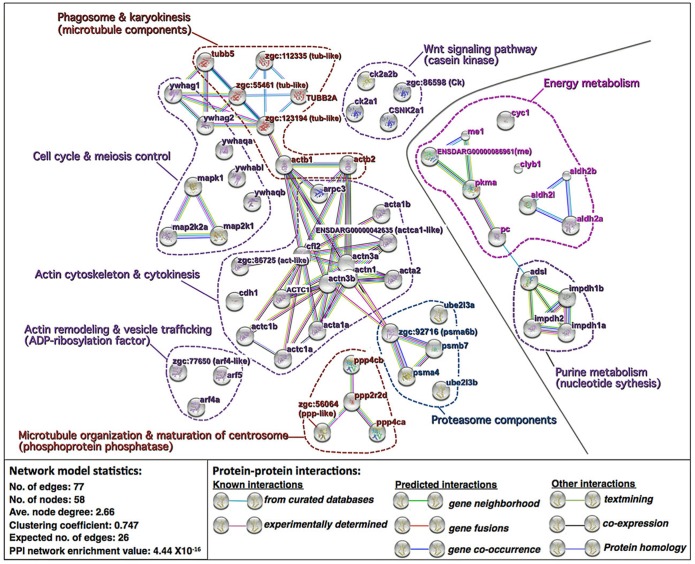
Network of differentially expressed proteins overexpressed in specific biological pathways.Shown are the results of Search Tool for the Retrieval of Interacting Genes/Proteins (STRING) network analysis of the 74 non-redundant proteins that were differentially regulated in good versus poor quality eggs and were over-represented in specific biological pathways in the PANTHER Pathways enrichment analyses (S3 Table). Proteins up-regulated in good quality eggs are shown to the right of the solid grey line and proteins up-regulated in poor quality eggs are shown to the left of the line. Each network node (sphere) represents all proteins produced by a single, protein-coding gene locus (splice isoforms and post-translational modifications collapsed). Only nodes representing query proteins are shown. Nodes are named for the transcript(s) to which spectra were mapped, with the text colored according to the processes shown in Fig 2; for full protein names, see S1 and S2 Tables. Small nodes represent proteins of unknown 3D structure. Large nodes represent proteins for which some 3D structure is known or predicted. Edges (lines) represent protein-protein associations meant to be specific and meaningful, i.e. proteins jointly contribute to a shared function but do not necessarily physically interact. Model statistics are presented at the lower left. Explanation of edge colors is given on the lower right. Dashed lines encircle groups of transcripts involved in the named biochemical pathways or physiological processes. See text for details.